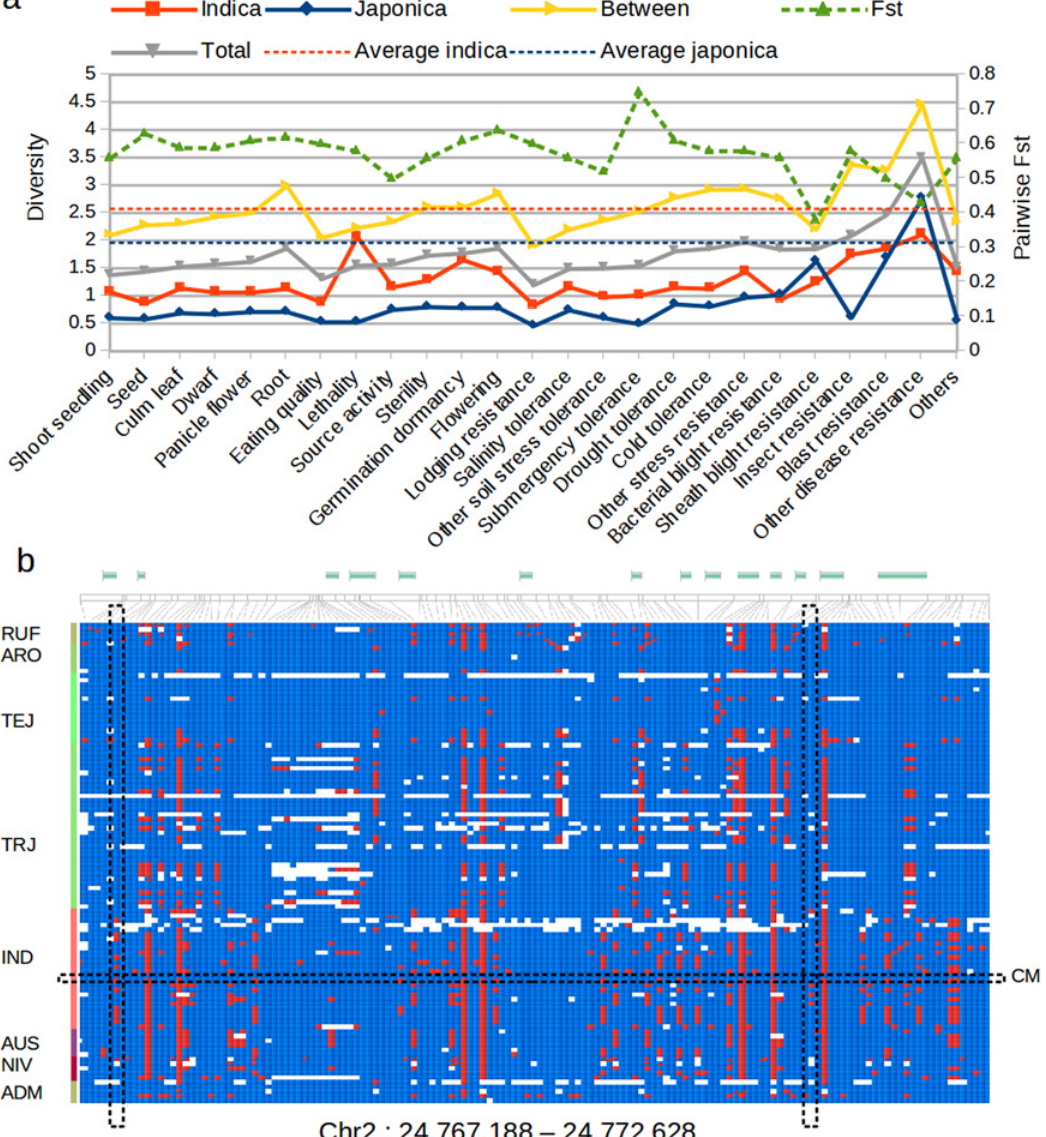
Fig 3. Diversity within agronomically important genes. a) Average diversity (average number of pairwise differences per kilobasepair) for genes grouped following the minor categories defined in the OGRO database. Red and blue dashed lines indicate average diversity values across the whole genome (including non-genic regions) within indica and within japonica respectively. The green dashed line, showing the average pairwise Fst between indica and japonica, is scaled in the secondary Y axis. b) SNPs identified within the gene LOC_Os02g40860 in the 104 varieties analyzed in this study. Characteristic alleles of the temperate japonica haplotype are painted blue. Vertical dashed rectangles show the locations of the two missense SNPs with high minor allele frequency within indica. The horizontal rectangle shows the haplotype of the variety Camponi. Colors in the left panel differentiate the following groups: O. rufipogon (RUF), aromatic (ARO), temperate japonica (TEJ), tropical japonica (TRJ), indica (IND), aus (AUS), O. nivara (NIV), and admixed (ADM).